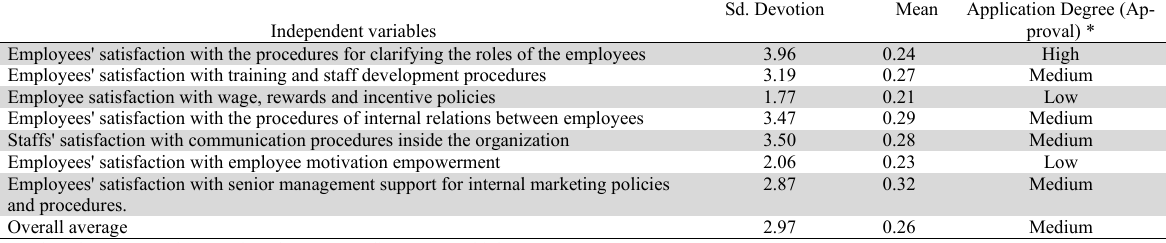
Arithmetic mean and standard deviation of the satisfaction of employees at Prince Sattam bin Abdulaziz University on their application of various policies and procedures related to internal marketing